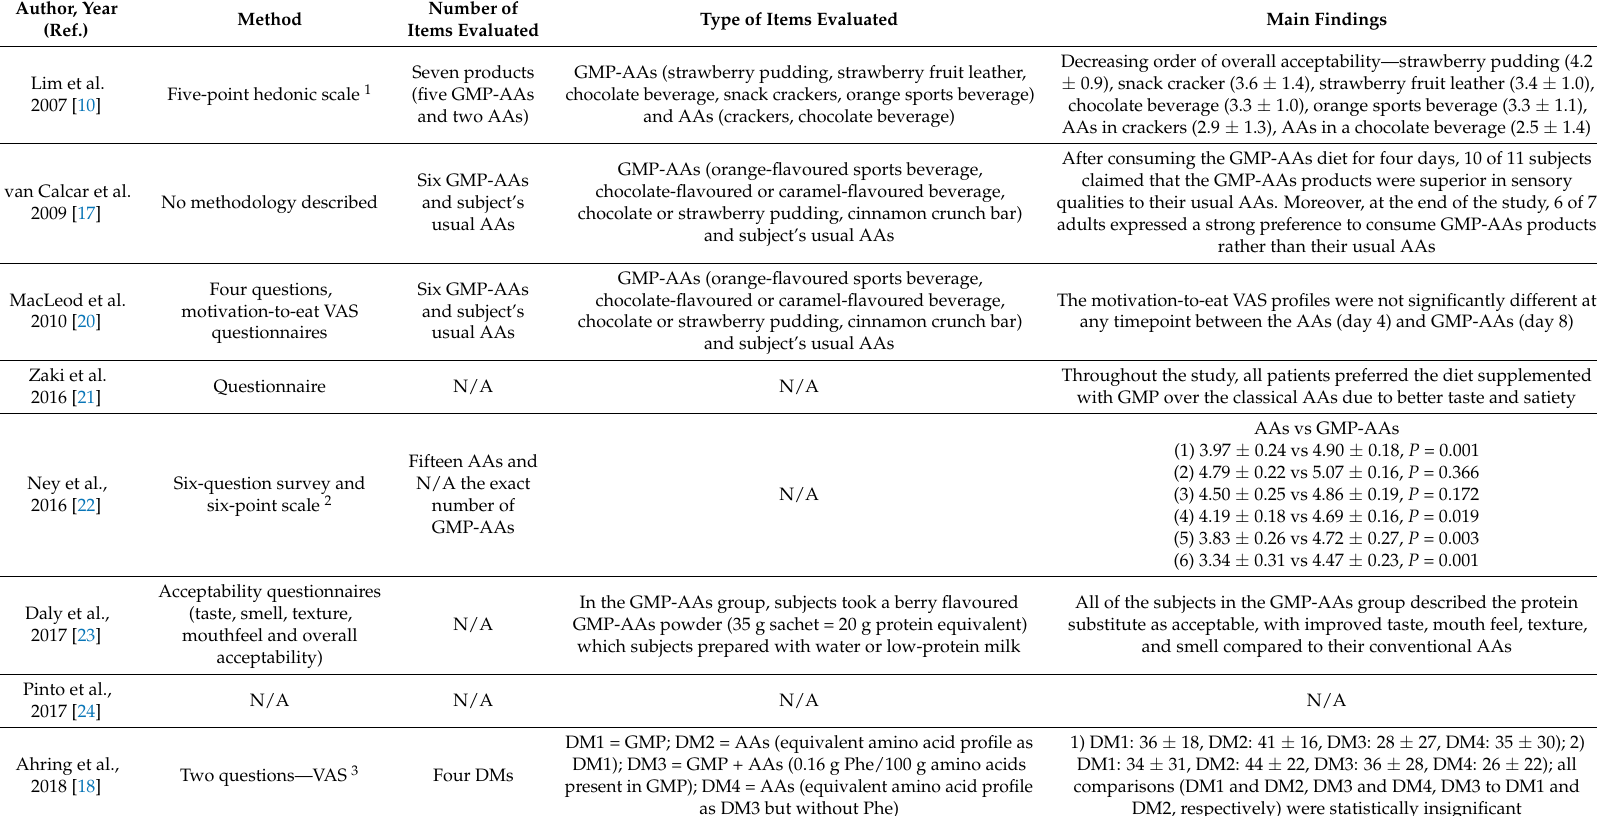
Table 3. Acceptability of GMP products versus